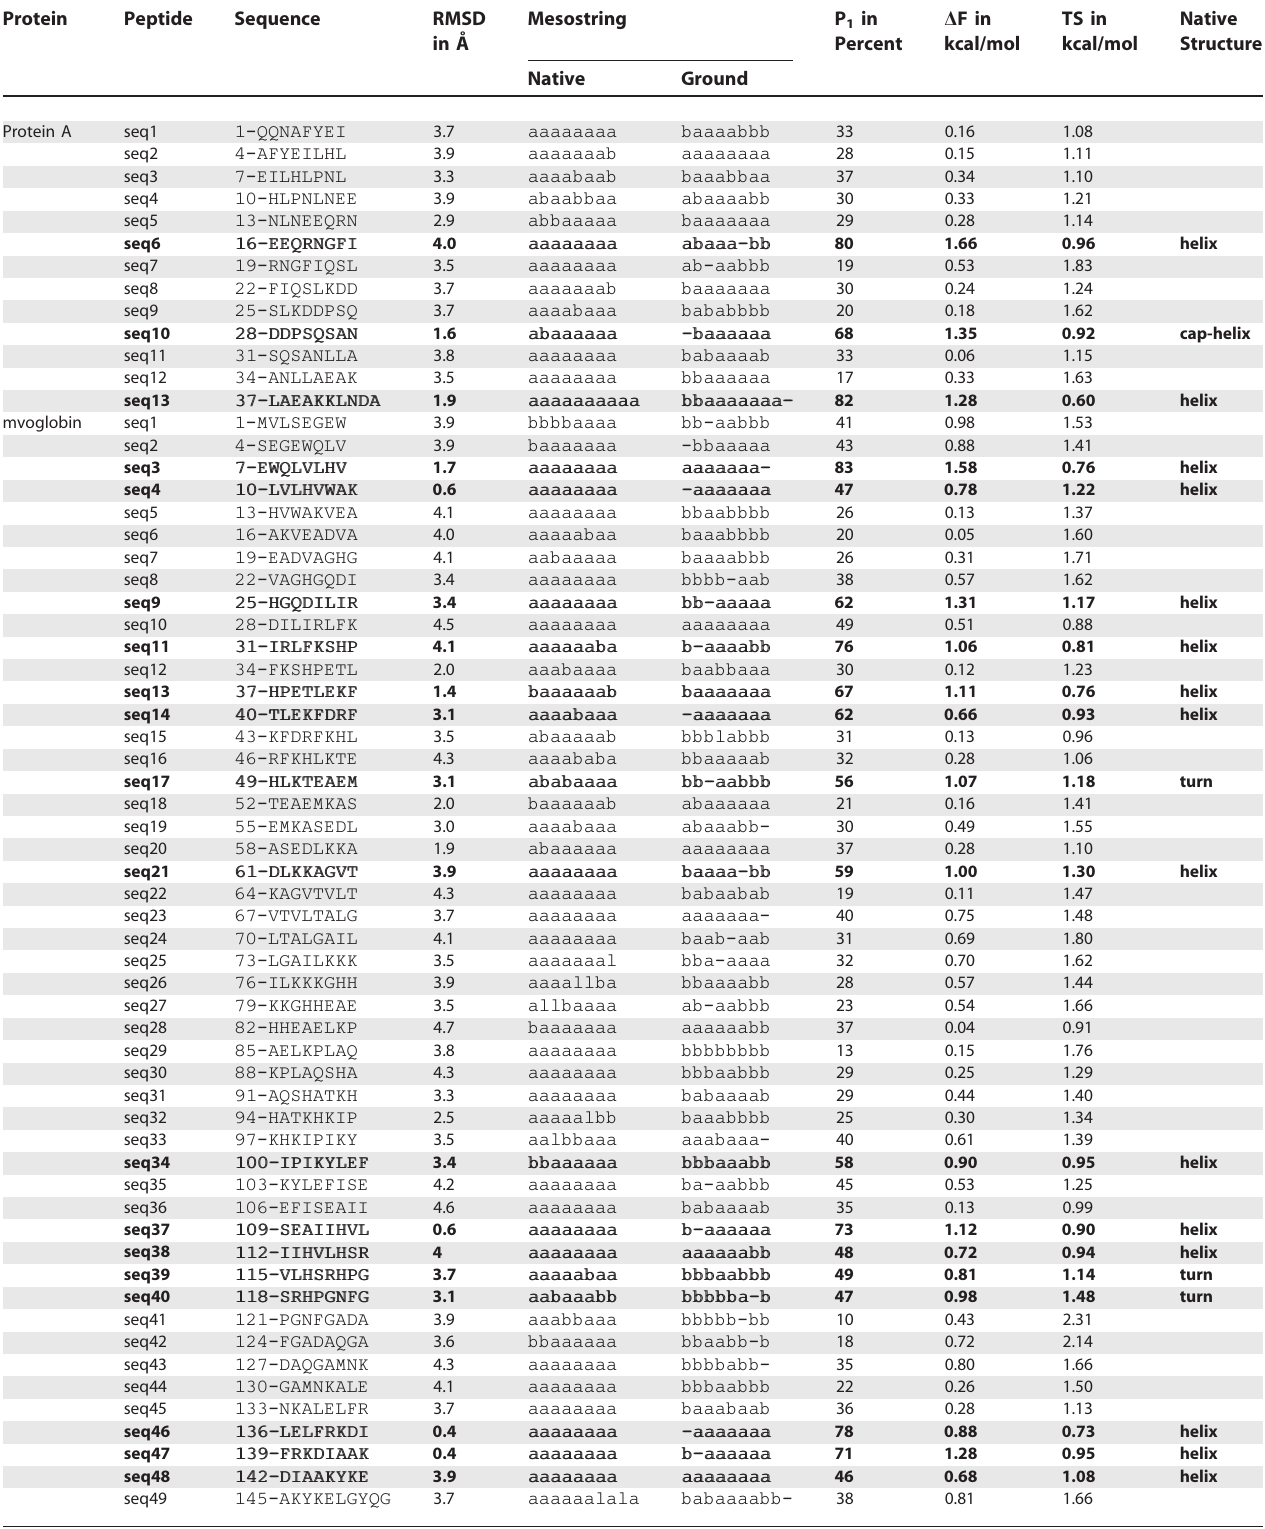
Native kcal/mol Structure